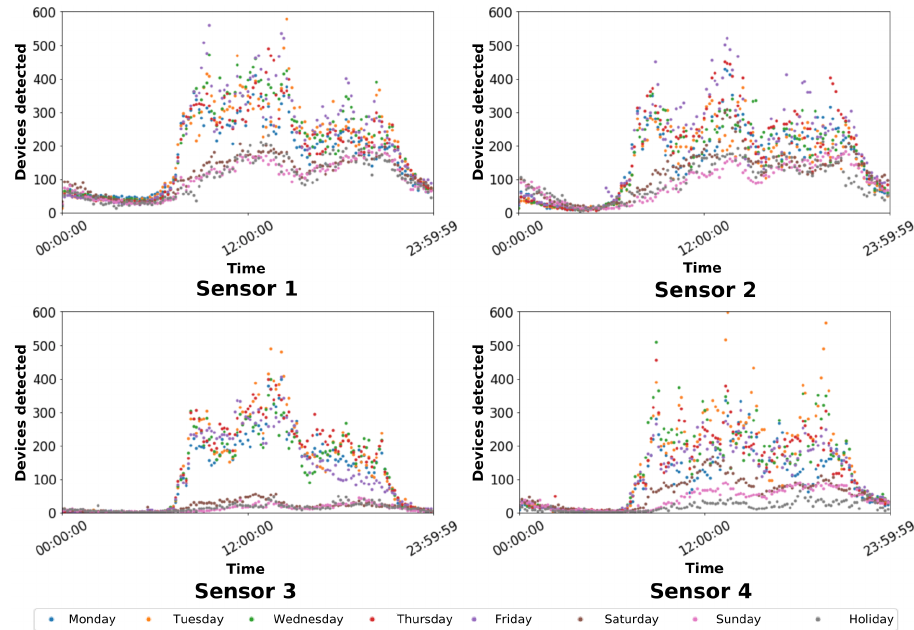
Figure 6. Number of devices detected over the day grouped by the week days and holidays.